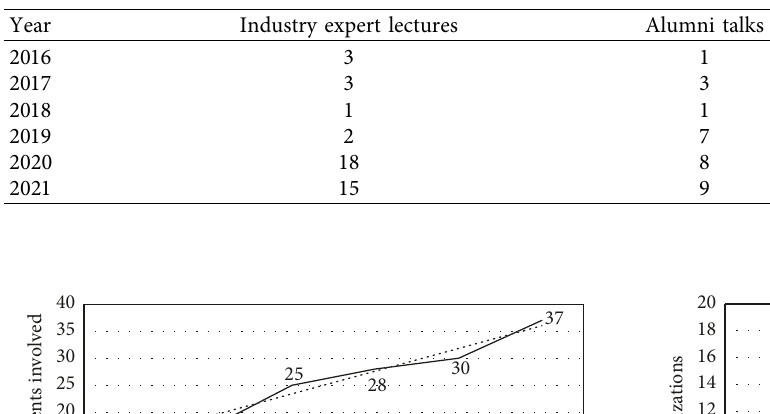
Table 5: Industry guest speakers.